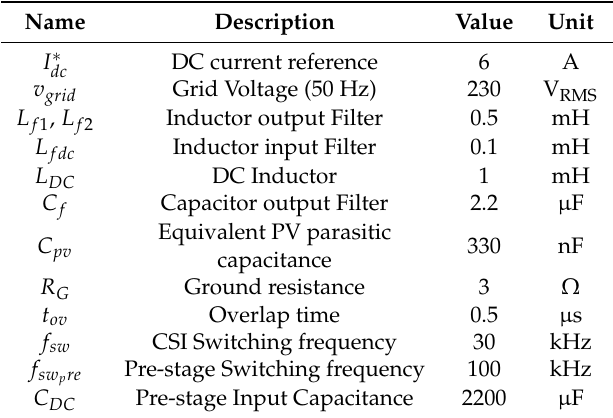
Table 2. Parameters used in the simulations.